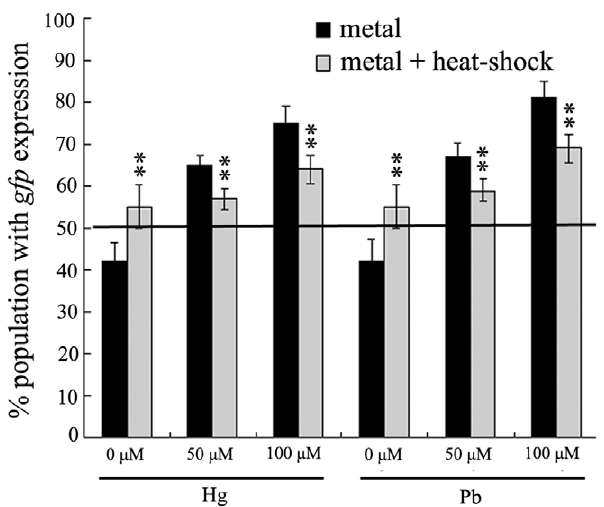
Figure 4. Effects of pre-treatment with mild heat-shock on the stress responses induced by metal exposure in wild-type N2 nematodes. L2-stage larvae animals were heat stressed for 1 h at 36 u C. The exposed metal concentrations were 50 and 100 m M. To evaluate the stress response, significant induction of hsp-16.2 :: gfp expression (50% of a population, above the line) was observed in wild- type N2 animals. Bars represent means 6 S.D. * p , 0.05 vs metal; ** p , 0.01 vs